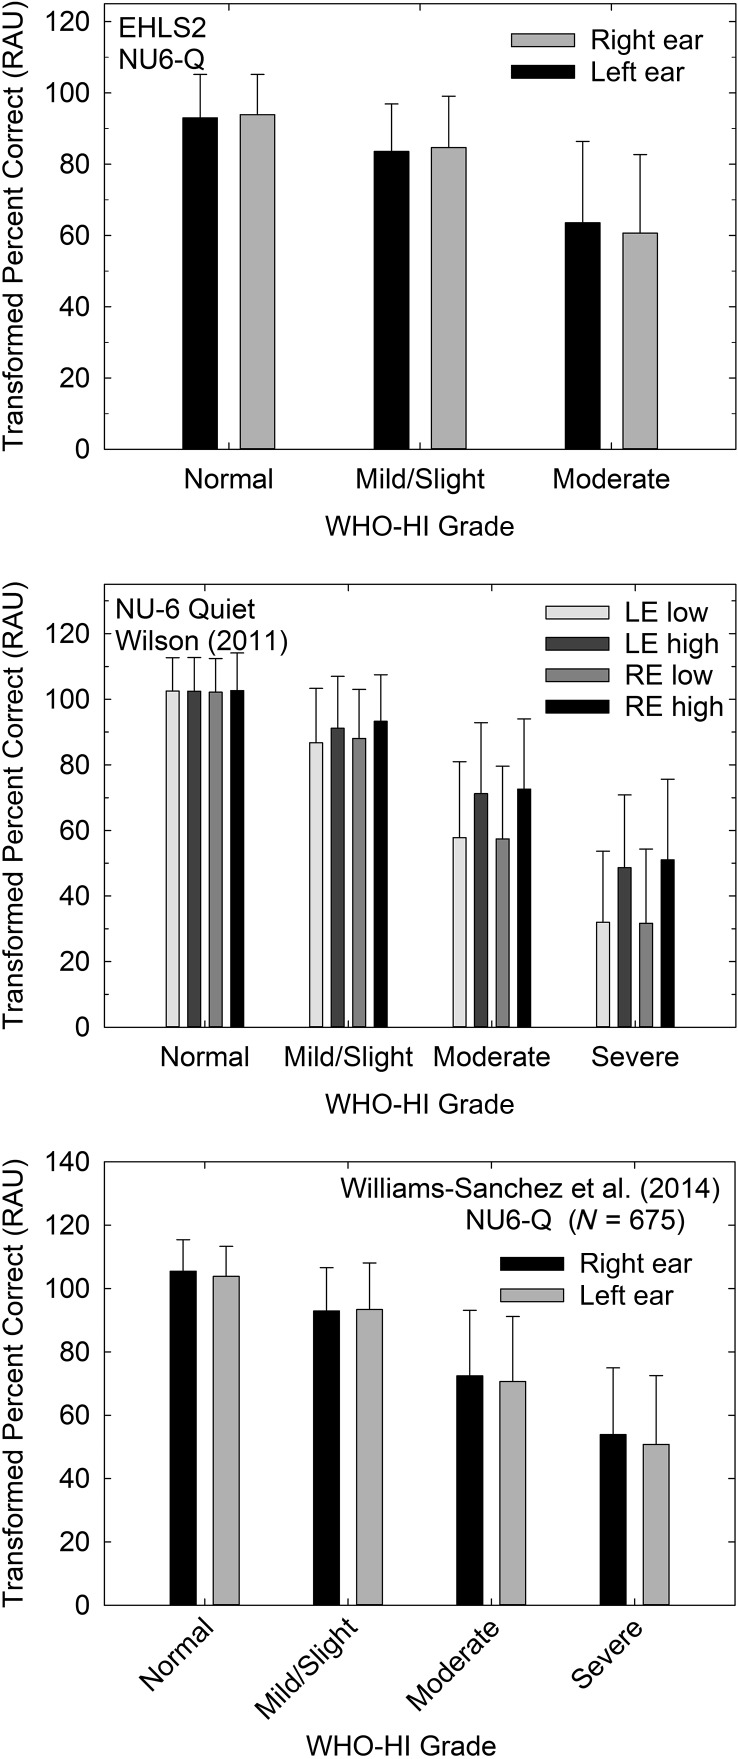
Means (+1 SD) for the rationalized arcsine unit (RAU)-transformed percent correct scores for the Northwestern University Auditory Test No. 6 (NU-6) speech recognition test from the Epidemiology of Hearing Loss Study-2 (EHLS2; top), Wilson (2011; middle), and Williams-Sanchez et al. (2014; bottom) data sets. Data for each ear plotted separately as a function of the ear-specific World Health Organization (WHO) hearing impairment (HI) grade in each panel. Data from Wilson in the middle panel are for all four combinations of ear (right ear [RE], left ear [LE]) and presentation level (low, high) used in that study.